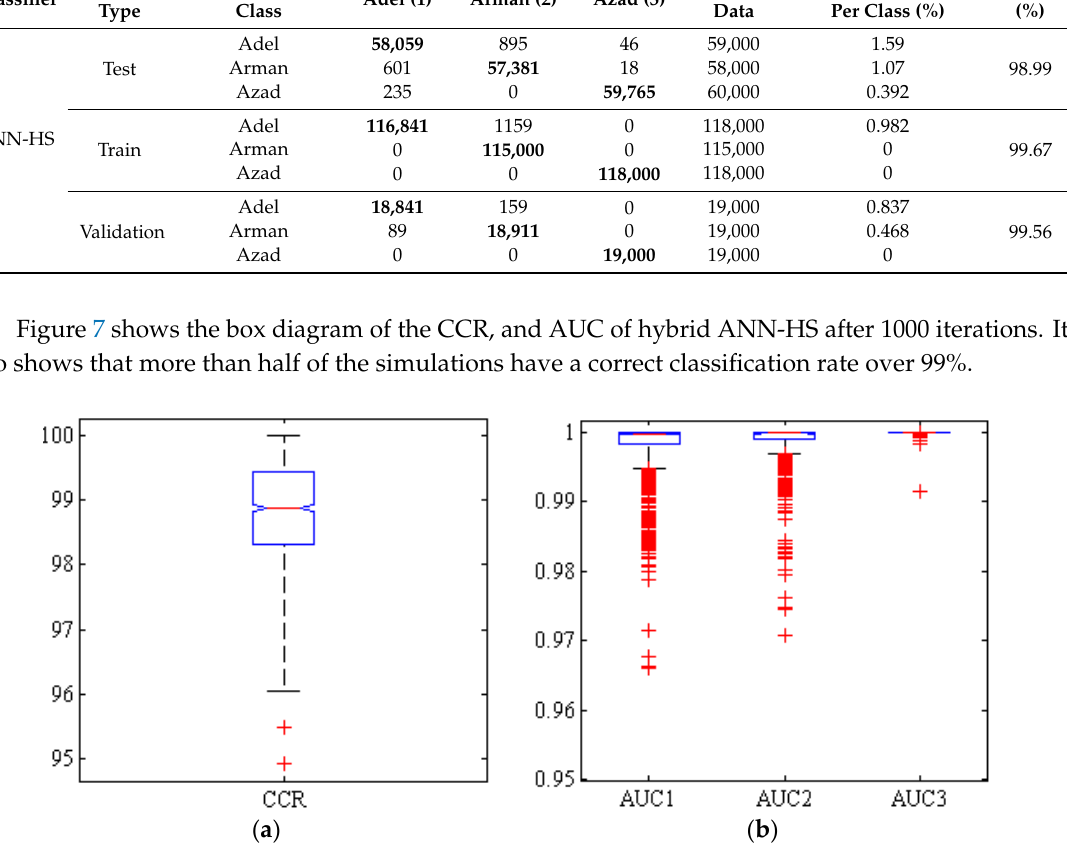
Table 7. Confusion matrix including correct classification rate (CCR) for ANN-HS classifier: Adel, Arman and Azad chickpea ( Cicer arietinum L.) varieties (1000 uniform random iterations, test train and validation sets).